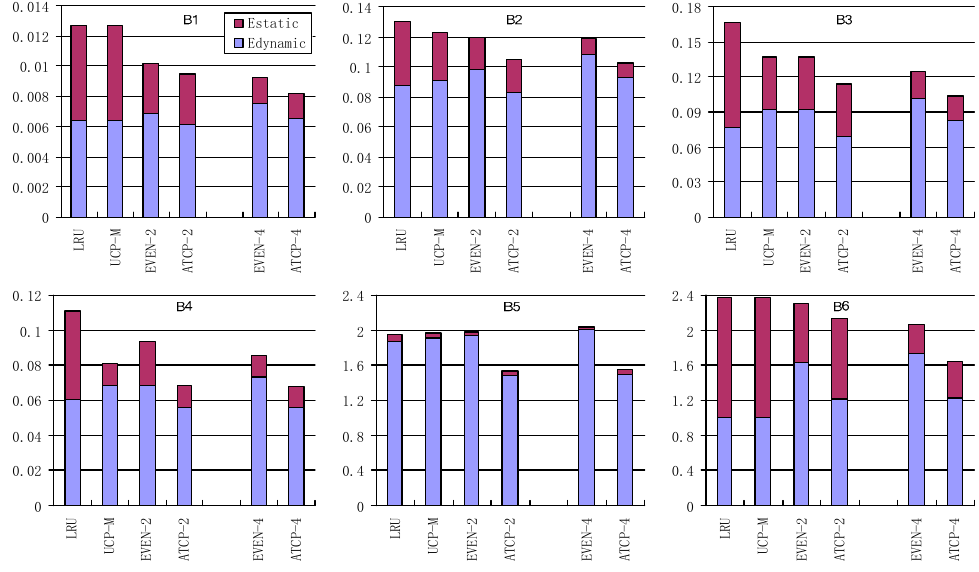
Figure 11. Energy consumed by L2 for single-item mix-mode workloads.